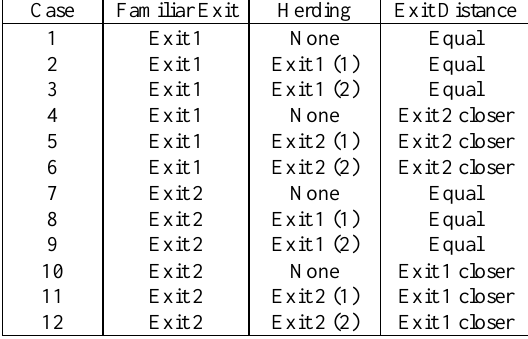
Table 1. Case setup for scenario 1